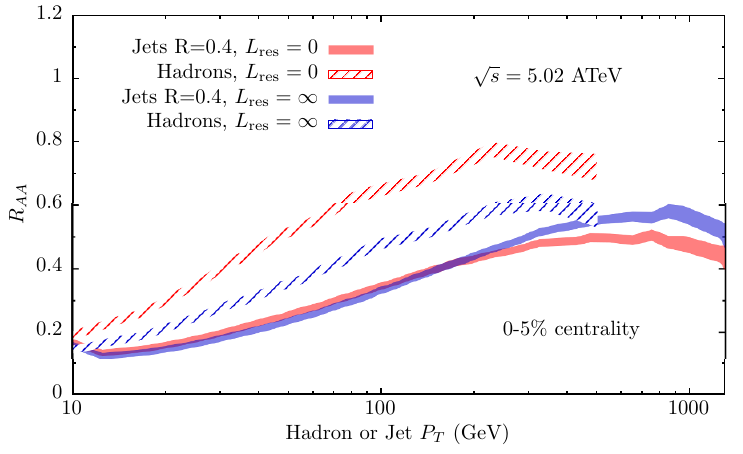
Figure 9 . Comparison of our hybrid model calculations of R had and L res = 1 . The results correspond to 0{5% central PbPb collisions with